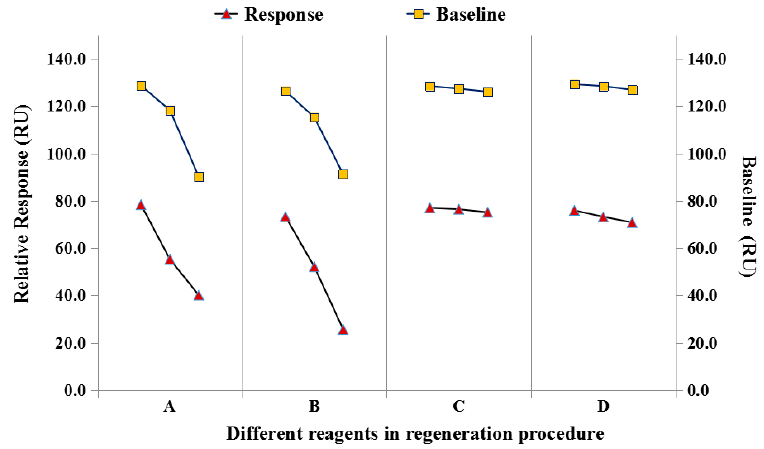
Figure 6. Comparison of baseline and relative response using different regeneration reagents: (A) 0.05 mol·L − 1 NaOH; (B) 0.5% SDS; (C) 0.1 mol·L − 1 HCl; (D) 0.01 mol·L − 1 Gly-HCl (pH 1.5). (A) 0.05 mol · L − 1 NaOH; (B) 0.5% SDS; (C) 0.1 mol · L − 1 HCl; (D) 0.01 mol · L − 1 Gly-HCl (pH